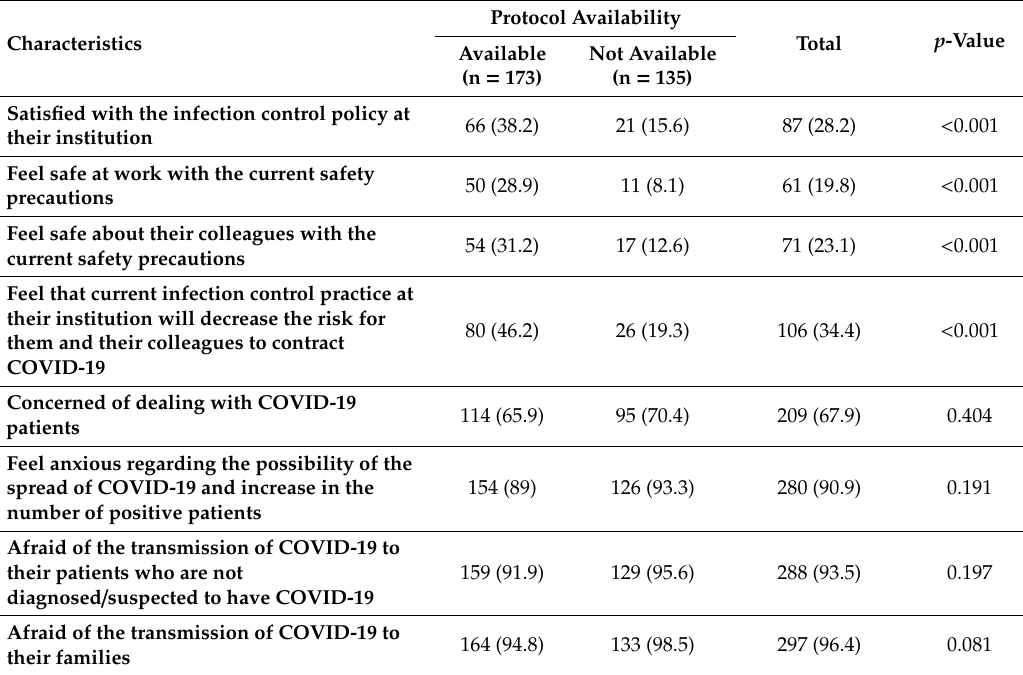
Table 5. The influence of the presence of a protocol for dealing with COVID-19 patients on the psychological interactions and preparedness of frontline Jordanian doctors.